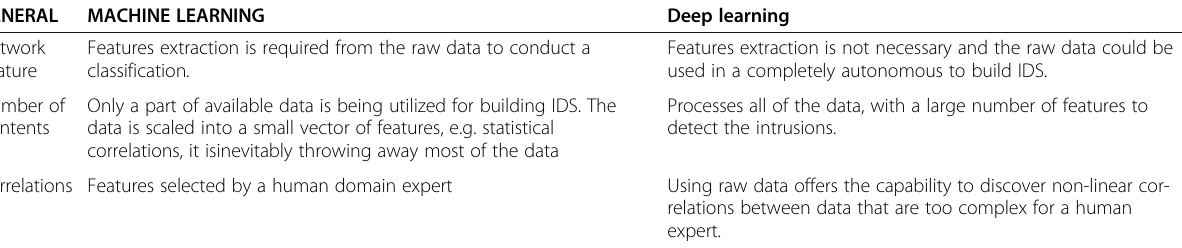
Table 4 Comparison of Machine learning and deep learning GENERAL MACHINE LEARNING Deep learning Network